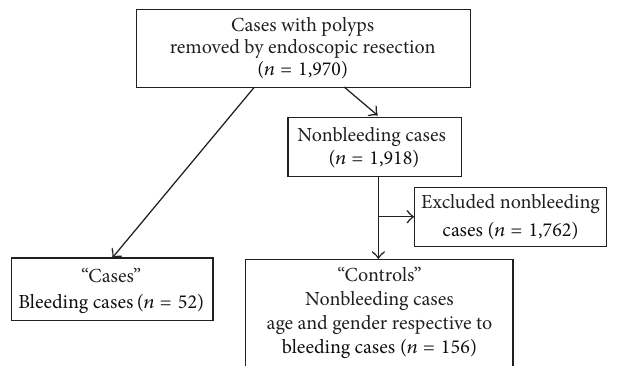
Figure 1: Flow diagram showing the process for analysis in the case- control study.